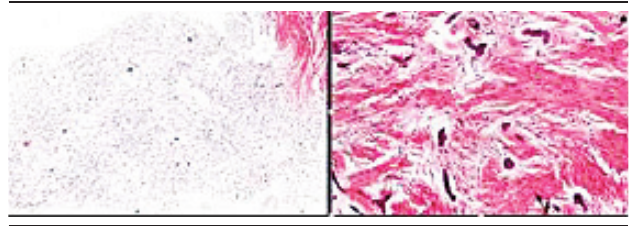
figurE 3 − Histopathological examination showing a mucosa covered by the parakeratinized stratified squamous epithelium, dense connective tissue with zones of proliferation of spindle and oval cells amid deposition of mineralized trabeculae (10× magnification)